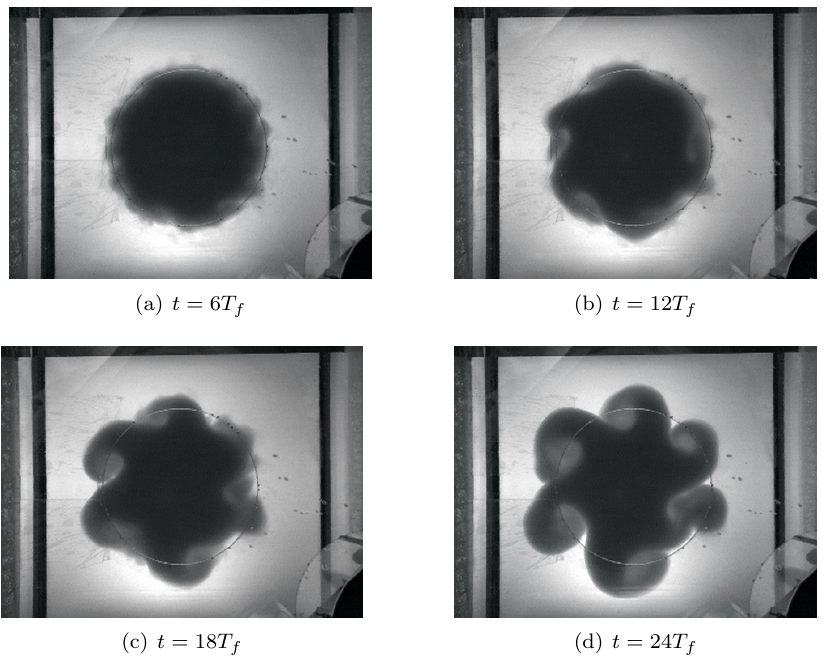
Figure 4. Snapshots of the evolution of the flow during a developing instability with wavenumber m = 6 observed in the laboratory experiment. Small-scale dissipative processes during the initial adjustment are visible in the first snapshot. Estimated eddy parameters are δ ≈ 0.17, Q 1 ≈